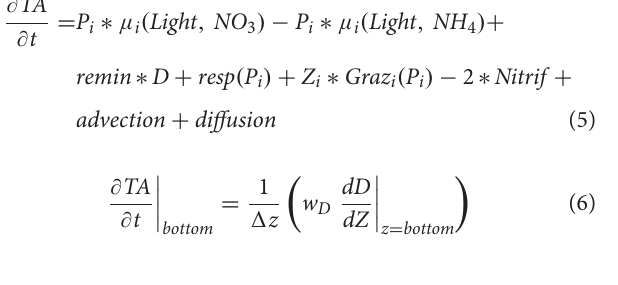
TABLE 1 | Seasonal concentrations of DIC and TA in freshwater